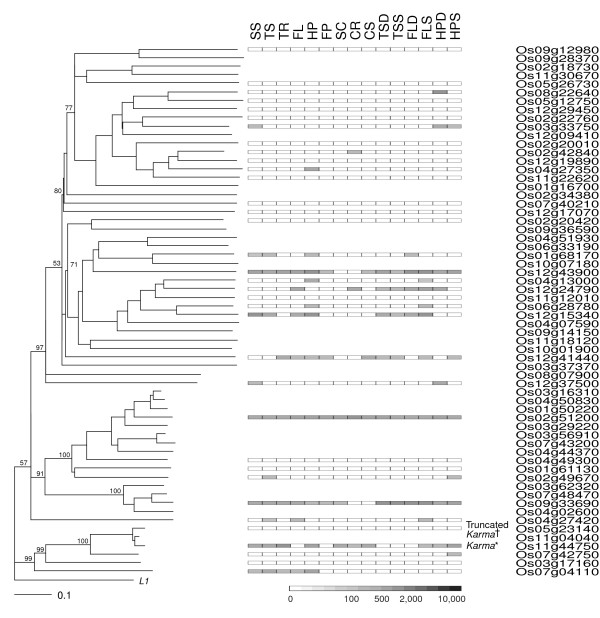
Degrees of lineage-specific transcription in the LINE superfamily. The phylogenetic tree was generated from a multiple alignment of conceptually translated sequences by using neighbor-joining methods and rooted with human L1. Bootstrap values were calculated from 1,000 replicates. Sample numbers are identical to those in Table 2. Shades of gray indicate the magnitude of transcription signals, which are based on microarray hybridization signals without units. Names of previously reported members are shown. *Previously reported members with transcription or transposition. † Previously reported inactivate members. LINE, long interspersed element.